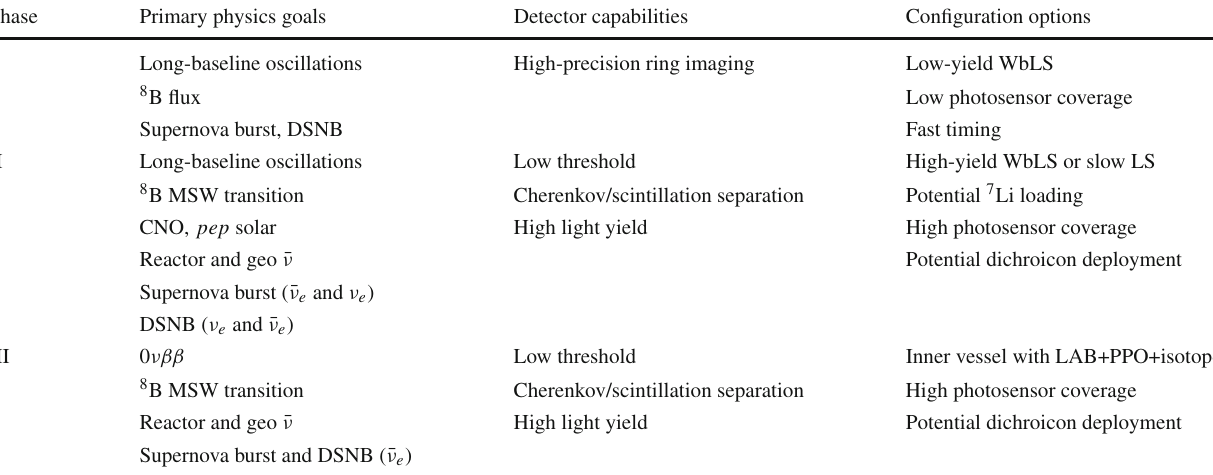
Table 2 Theia physics goals and phased program. Each successive phase adds to the breadth of the physics program. The configuration column lists potential approaches to each phase, rather than a finalized detector